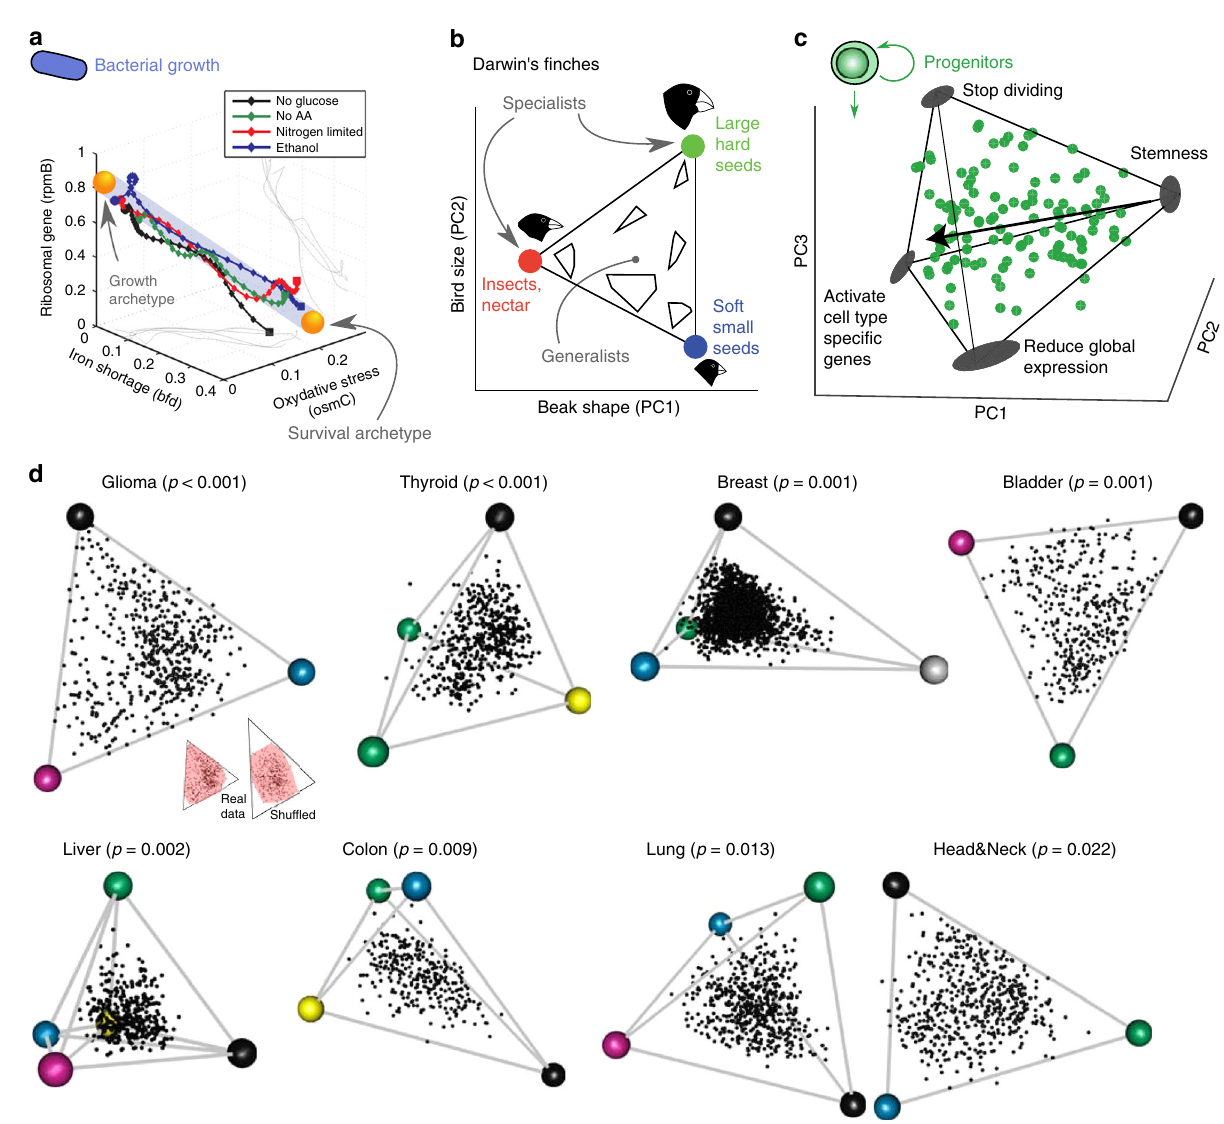
Fig. 1 Trade-offs between tasks leads to phenotypes arranged in a polyhedron, whose vertices are archetypes that specialize in one task, in situations ranging from bacterial gene expression to animal morphology to cancer. a 90% of the variation in E. coli gene expression falls on a line due to a trade-off between tasks of growth and survival. Axes are percent of total promoter activity. b Morphology of Darwin ’ s ground- fi nch species falls on a triangle. Specialists in different diets are found near the three archetypes, and generalist are near the center of the triangle. A and B adapted with permission from AAAS from Shoval et al. 23 . c Single-cell gene expression of mouse intestinal progenitor cells fall on a tetrahedron, shown in principal components (PC) space. The four archetypal gene expression pro fi les correspond to fundamental progenitor cell tasks. Adapted from Korem et al. 29 . d Tumor gene expression pro fi les of eight cancer types fall on polyhedra. Individual tumors (dots) plotted in the space spanned by the fi rst three gene expression PCs (TCGA, breast cancer from Metabric). Archetype (colored dots) number and position were inferred using ParTI. Inset: shuf fl ed data has a convex hull (CH, pink) that fi lls less of the minimal enclosing (ME) triangle than the real data. The ratio of the CH area (or volume) and ME triangle area (or tetrahedron volume) was used to compute statistical signi fi